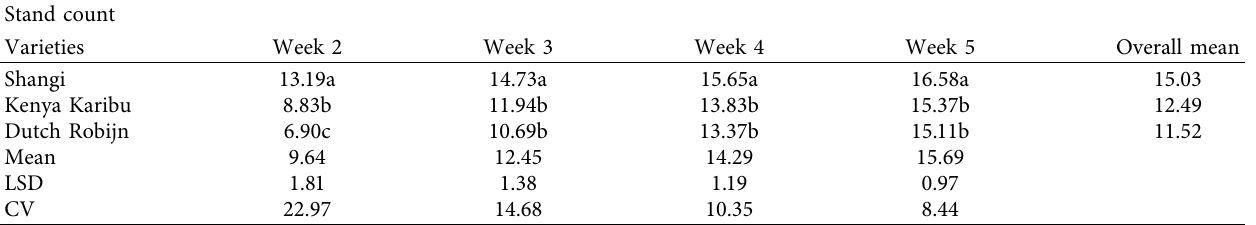
Table 7: The mean comparison of three potato varieties on germinated plants (stand count) at different weeks after planting. Stand count